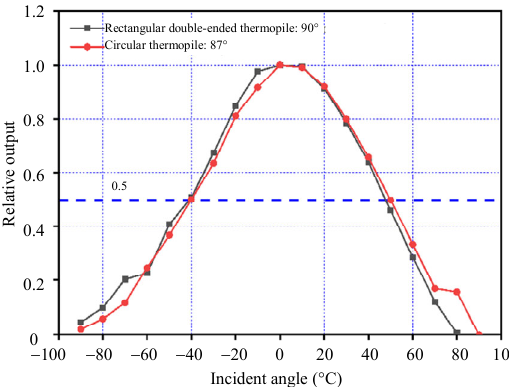
Fig. 13 Field of view of two structures of